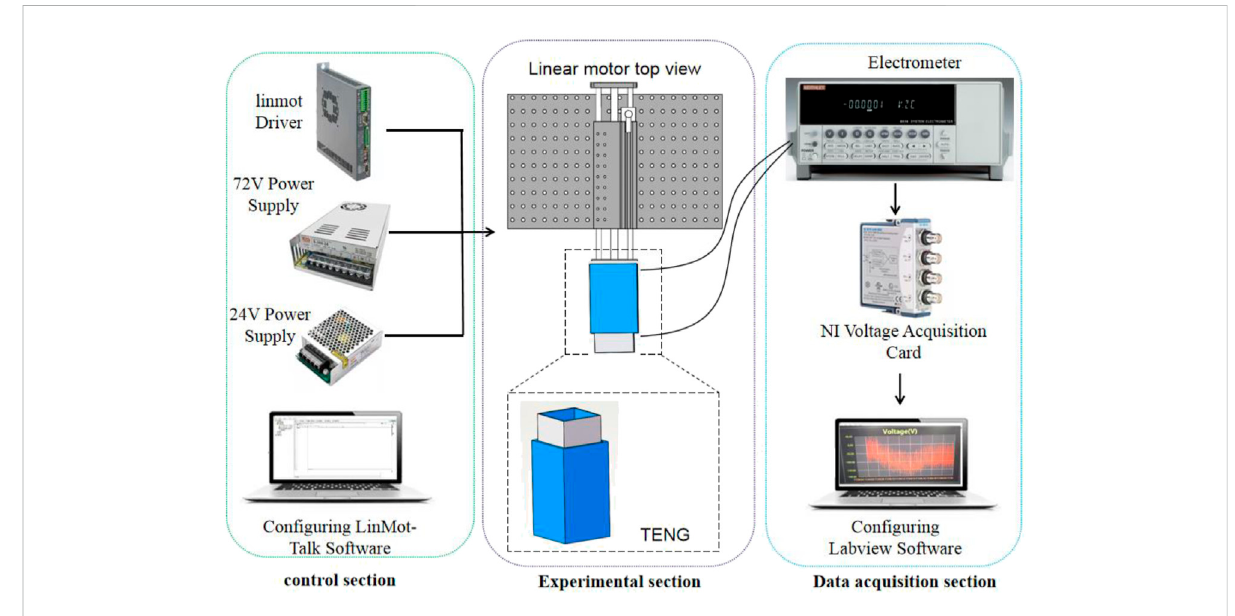
FIGURE 2 Schematic diagram of the TENG output performance test